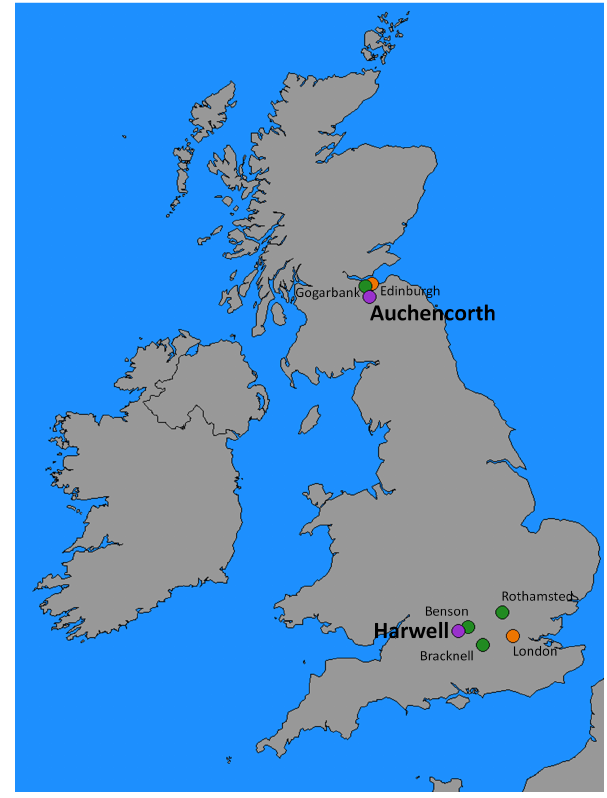
Figure 1. Map of the United Kingdom and Ireland showing the lo- cation of the two UK EMEP supersites (purple circles) at Auchen- corth and Harwell, as well as the location of the UK Met Office stations from which meteorological data were used (green